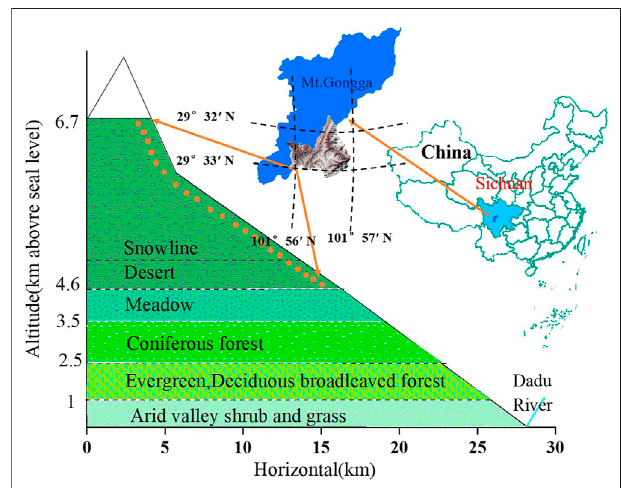
FIGURE 1 | The vertical vegetation zonation and climatic conditions on the eastern slope of Gongga Mountain, according to Zhong et al. (1999), Thomas (1997) and Jia et al.